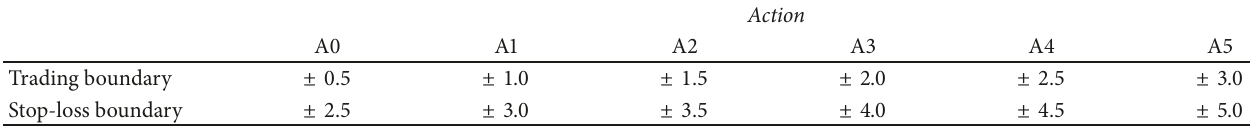
Table 3: Setting a discrete action space.